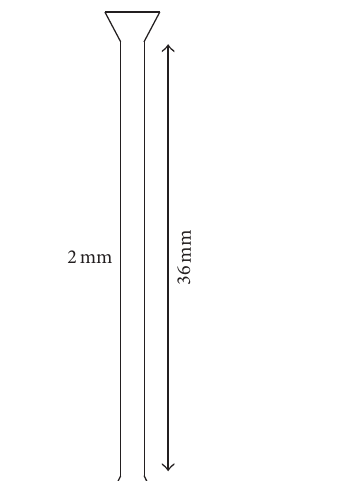
Figure 2: Orientation of leg and attached tendon and muscle. The legofa4-week-oldturkeypoultisfixedinthematerialtestingsystem apparatus. Metatarsus and foot are embedded and fixed at the base of the loading frame and gastrocnemius muscle (with a portion of tendon) is clamped to the upper moveable hydraulic arm. The predetermined point of tendon failure is in the midregion of the exposed tendon